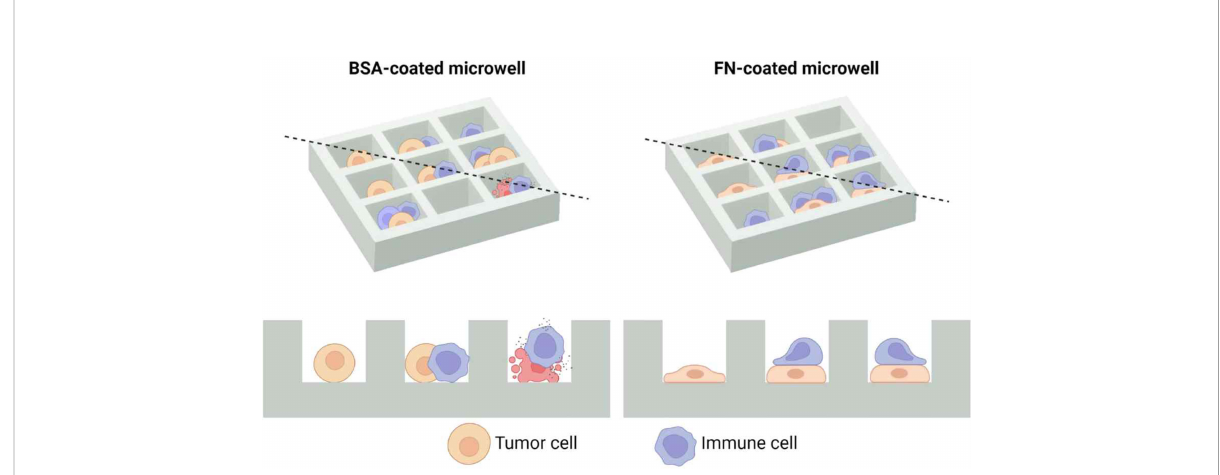
FIGURE 2 Schematic illustration of microwell arrays that can control adhesion status of solid tumor cells. As bovine serum albumin (BSA) does not allow cell adhesion, solid tumor cells in BSA-coated microwells will have a round morphology, whereas fi bronectin (FN) promotes cell adhesion, solid tumor cells in FN-coated microwells will have a fl at morphology. Top views are shown in the upper panel, and cross sectional views across the black dashed lines are shown in the lower panel. Created with BioRender.com.